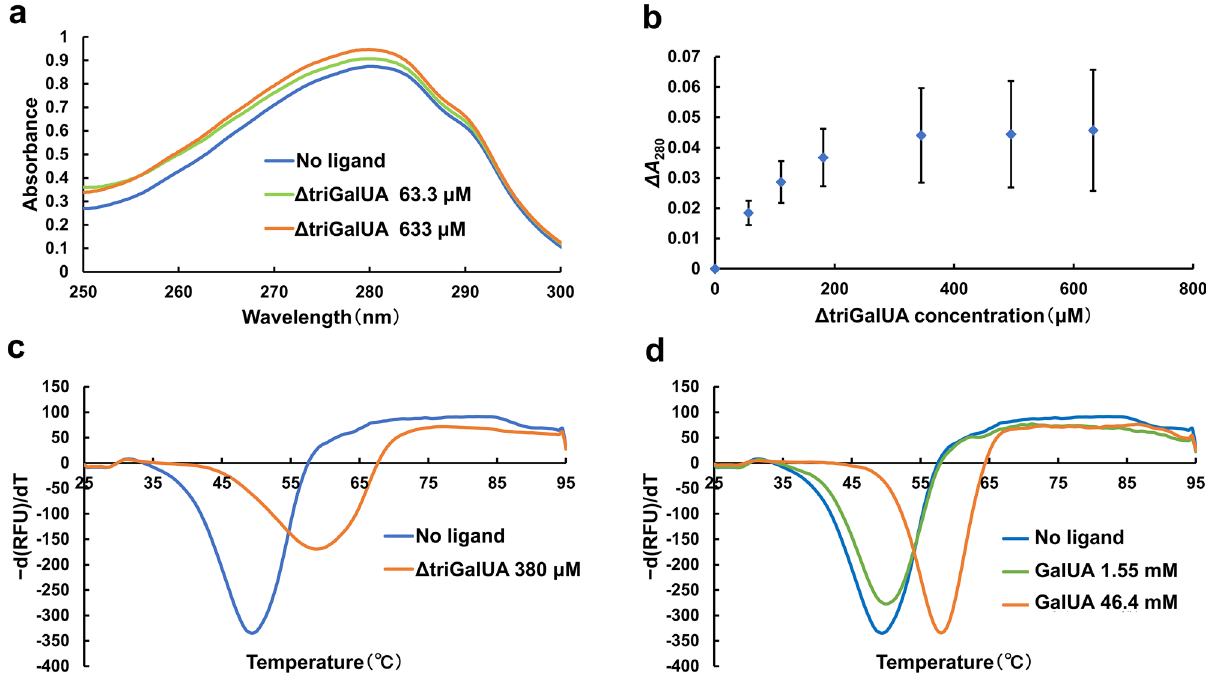
Figure 1. Binding assay of SPH1118 with ΔtriGalUA and GalUA. ( a ) The UV spectra of SPH1118 in the absence (blue) and presence of 63.3 μM (green) and 633 μM ΔtriGalUA (orange). ( b ) Differential absorbance at 280 nm ( ΔA 280 ) as a function of ΔtriGalUA concentration. Each data point represents the mean ± standard error (SE) from three independent experiments. ( c ) The negative derivative curve plots obtained from the fluorescence profiles of SPH1118 in the absence (blue) and presence of 380 μM ΔtriGalUA (orange). ( d ) The negative derivative curve plots obtained from the fluorescence profiles of SPH1118 in the absence (blue) and presence of 1.55 mM (green) and 46.4 mM GalUA